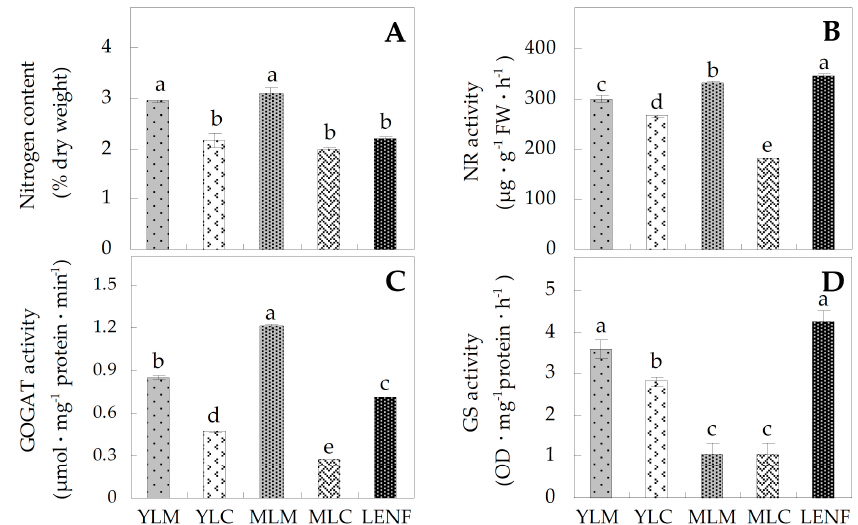
Figure 4. Nitrogen content and activities of nitrogen metabolism-related enzymes in various leaf regions at different development stages of Hosta “Gold Standard”. ( A ) Nitrogen content; ( B ) nitrate reductase (NR) activity; ( C ) glutamine α -oxoglutarate aminotransferase (GOGAT) activity; ( D ) glutamine synthetase (GS) activity. The values were determined in young leaf margin (YLM), young leaf center (YLC), mature leaf margin (MLM), mature leaf center (MLC), and leaf under excess nitrogen fertilization (LENF), which were presented as means ± SE ( n = 3). The different small letters on the columns indicate significant differences among various leaf regions at different development stages ( p < 0.05).